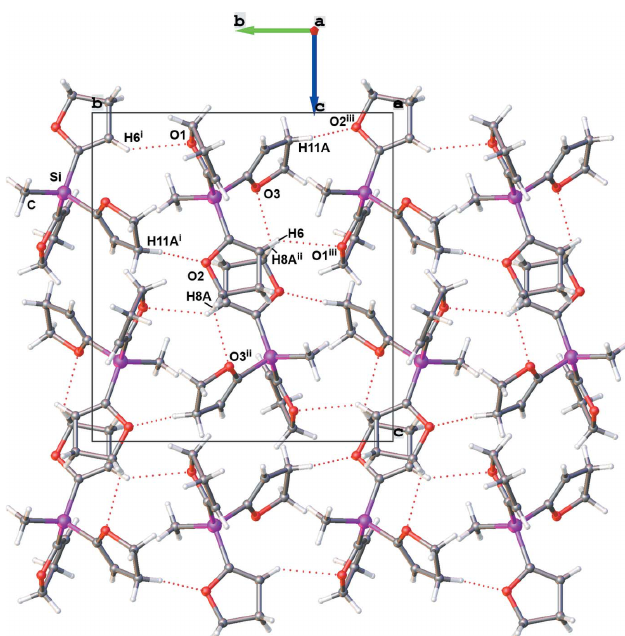
Figure 3 The crystal packing of compound 1 in a view along the a axis. C—H (cid:2)(cid:2)(cid:2) O hydrogen bonds are shown as dashed lines. [Symmetry codes: (i) (cid:5) x + 1 y + 1 , (cid:5) z + 1 ; (ii) (cid:5) x , (cid:5) y + 1, (cid:5) z + 1; (iii) (cid:5) x + 1 2 2